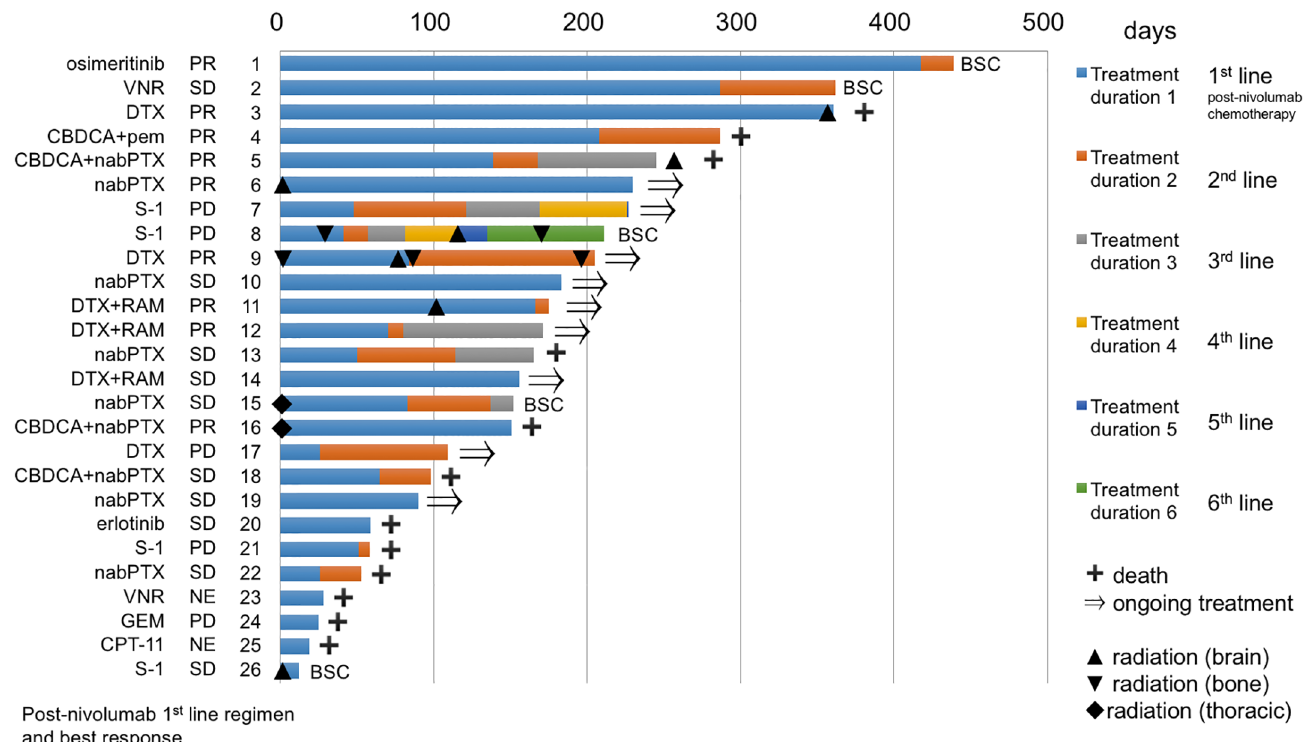
Fig 3. Course of treatment for each patient. Each bar indicates treatment duration for each patient. Treatment regimens, best response to each treatment, and patient numbers are described on the left side of each bar. On the right side of each bar, the status of each patient is shown. Diamond and triangle shapes represent radiation therapy in each patient. VNR; vinorelbine, DTX; docetaxel, CBDCA; carboplatin, pem; pemetrexed, nabPTX; nab-paclitaxel, RAM; ramucirumab, GEM; gemcitabine, CPT-11; irinotecan, SD; stable disease, PR; partial response, PD; progressive disease, NE; not evaluable; BSC; best supportive care.